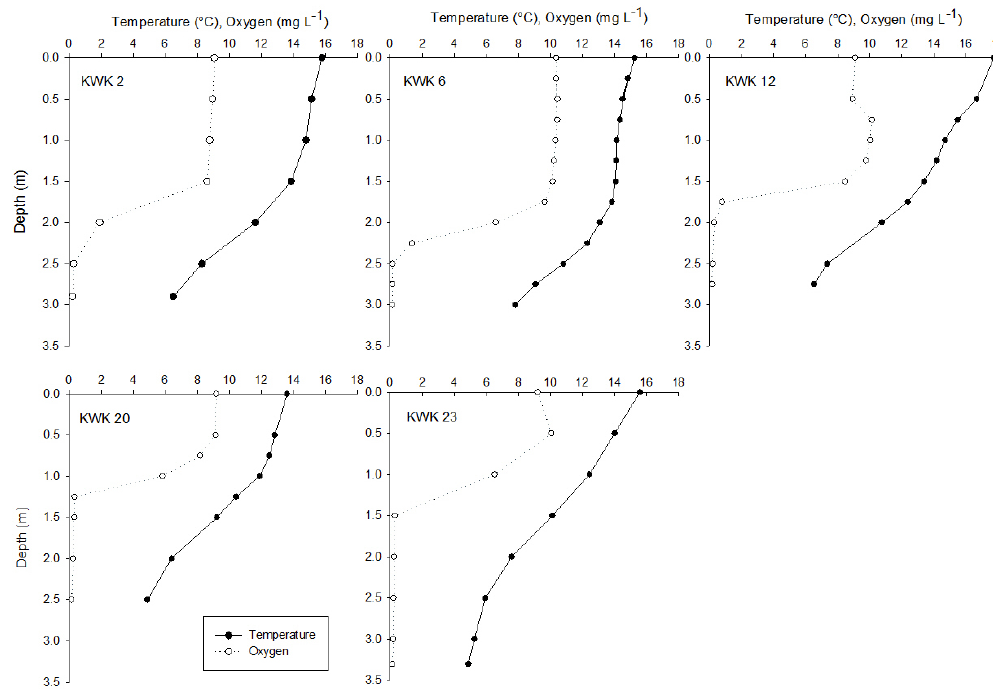
Figure 1. Summer temperature and oxygen profiles from sampled